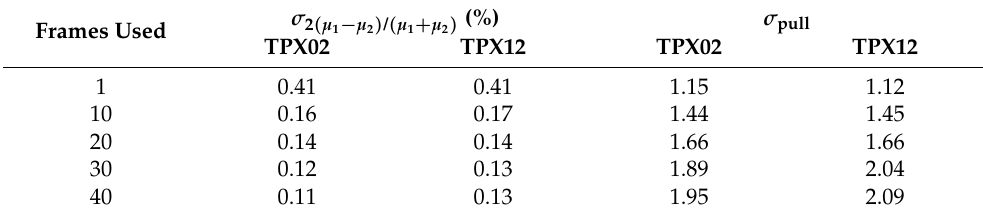
Table 18. Precision of TPX02 and TPX12 luminosity measurements between layers 1 and 2. The precision is given for 1 frame and for 10, 20, 30, and 40 frames combined. The width of the Gaussian fit σ 2 ( µ gives the precision of the measurement and σ pull gives the width of the fit of the 1 − µ 2 ) / ( µ 1 + µ 2 ) pull distribution with statistical uncertainties only. LHC fill 4449. Taken from Ref. [14].